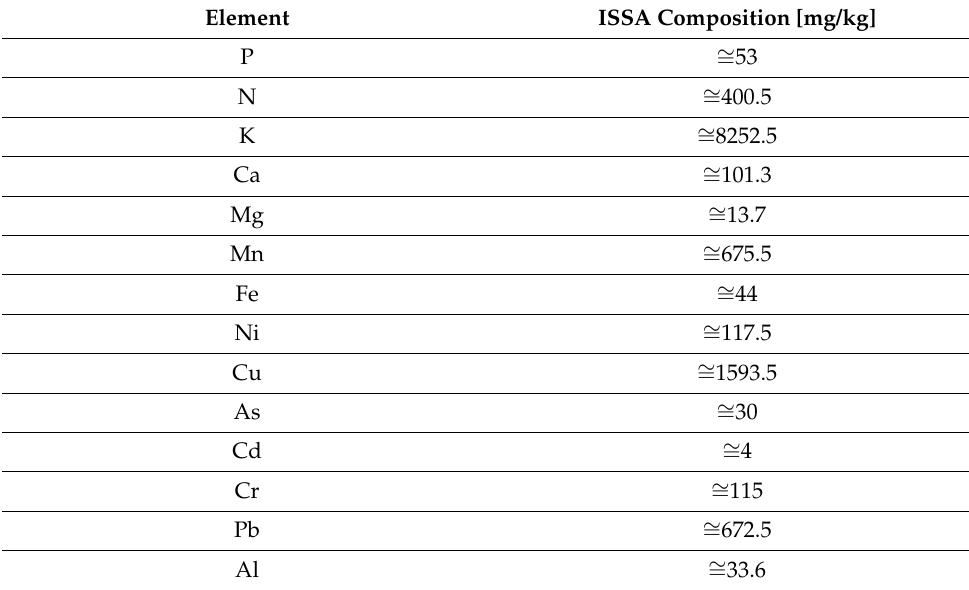
Table A2. Incineration sewage sludge ash (ISSA)